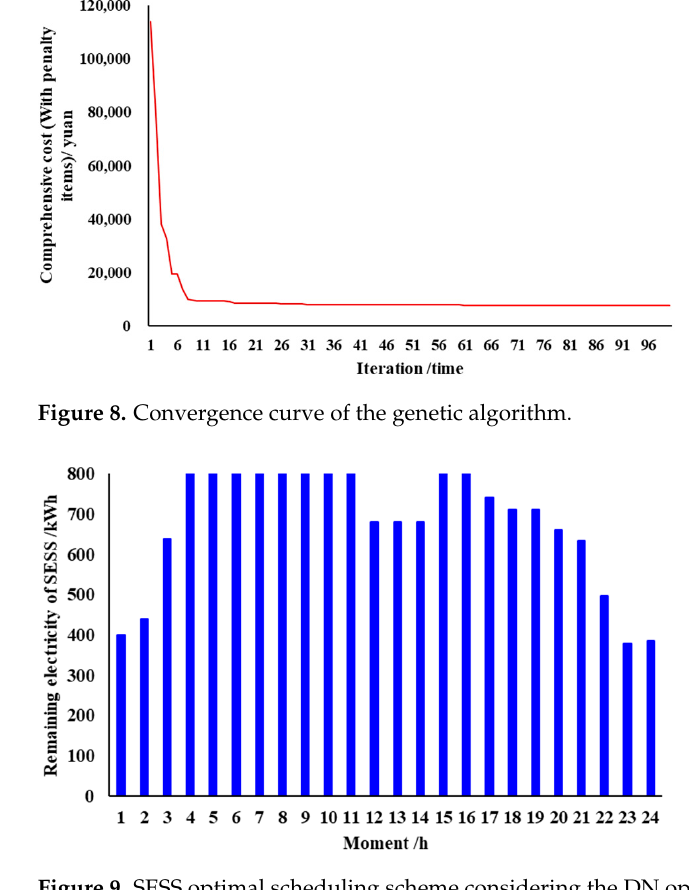
Figure 9. SESS optimal scheduling scheme considering the DN operation risk.